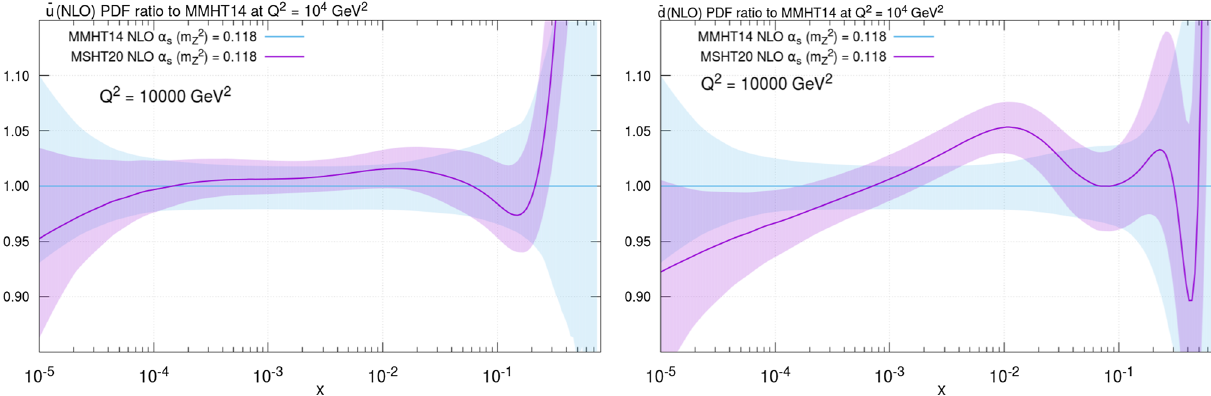
Fig. 32 (Left) Up antiquark, ¯ u , and (right) Down antiquark, ¯ d , PDF ratios to MMHT14 at NLO and Q 2 = 10 4 GeV 2